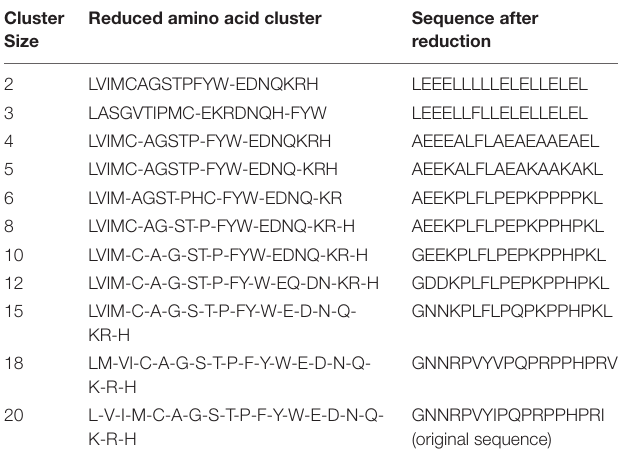
TABLE 2 | Reduction descriptors when reduced type is 1 and cluster size are